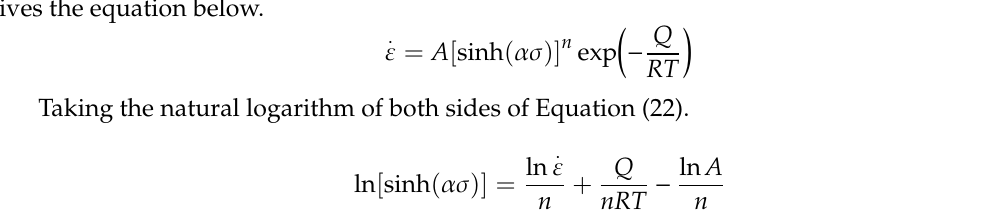
Figure 14. The relation between ln[sinh( ασ )] and ln ε at the strain of 0.3.